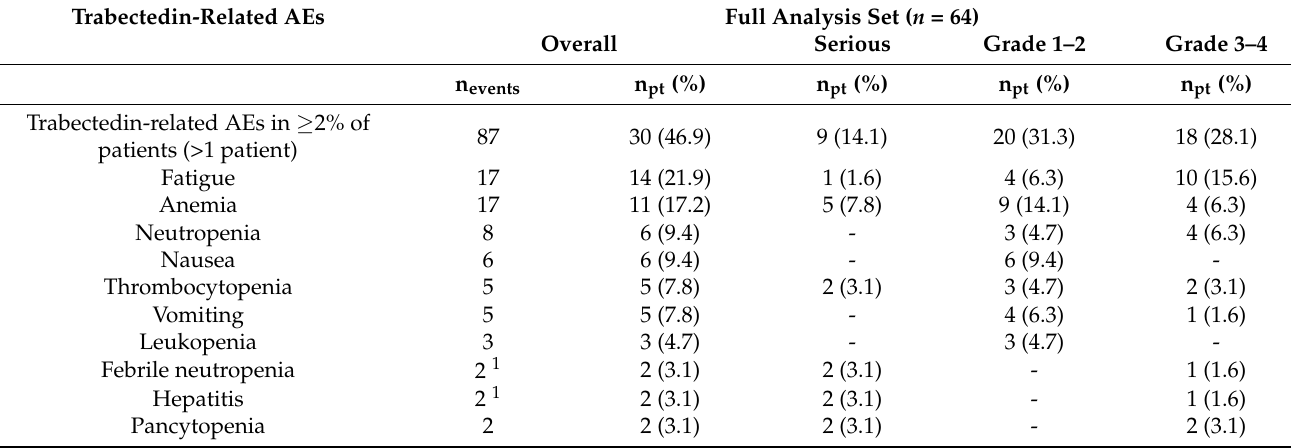
Table 5. Trabectedin-related adverse